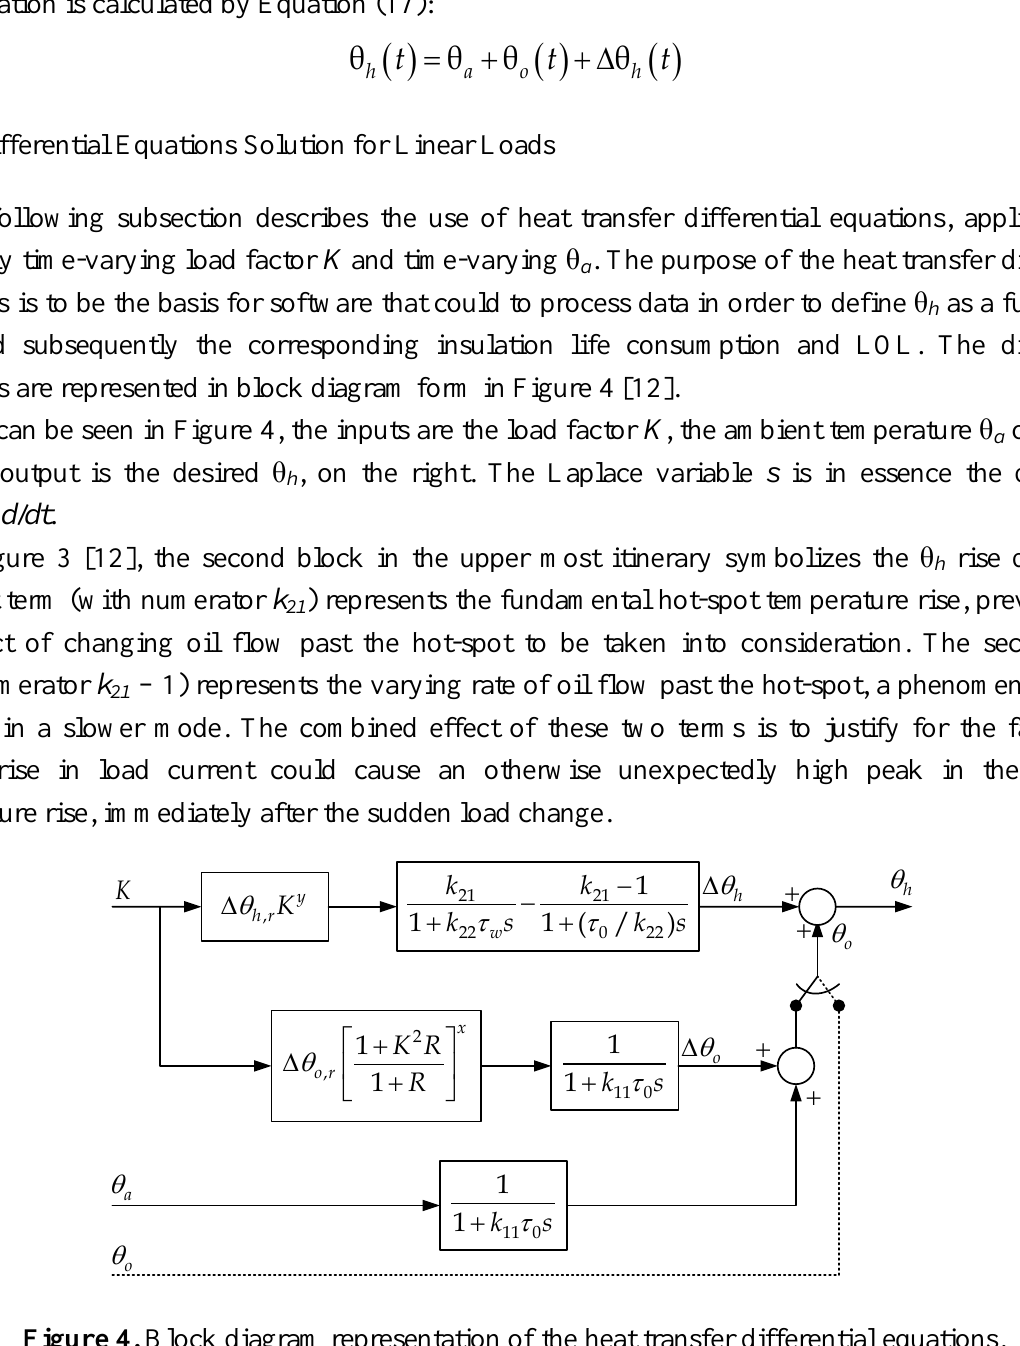
Figure 4. Block diagram representation of the heat transfer differential